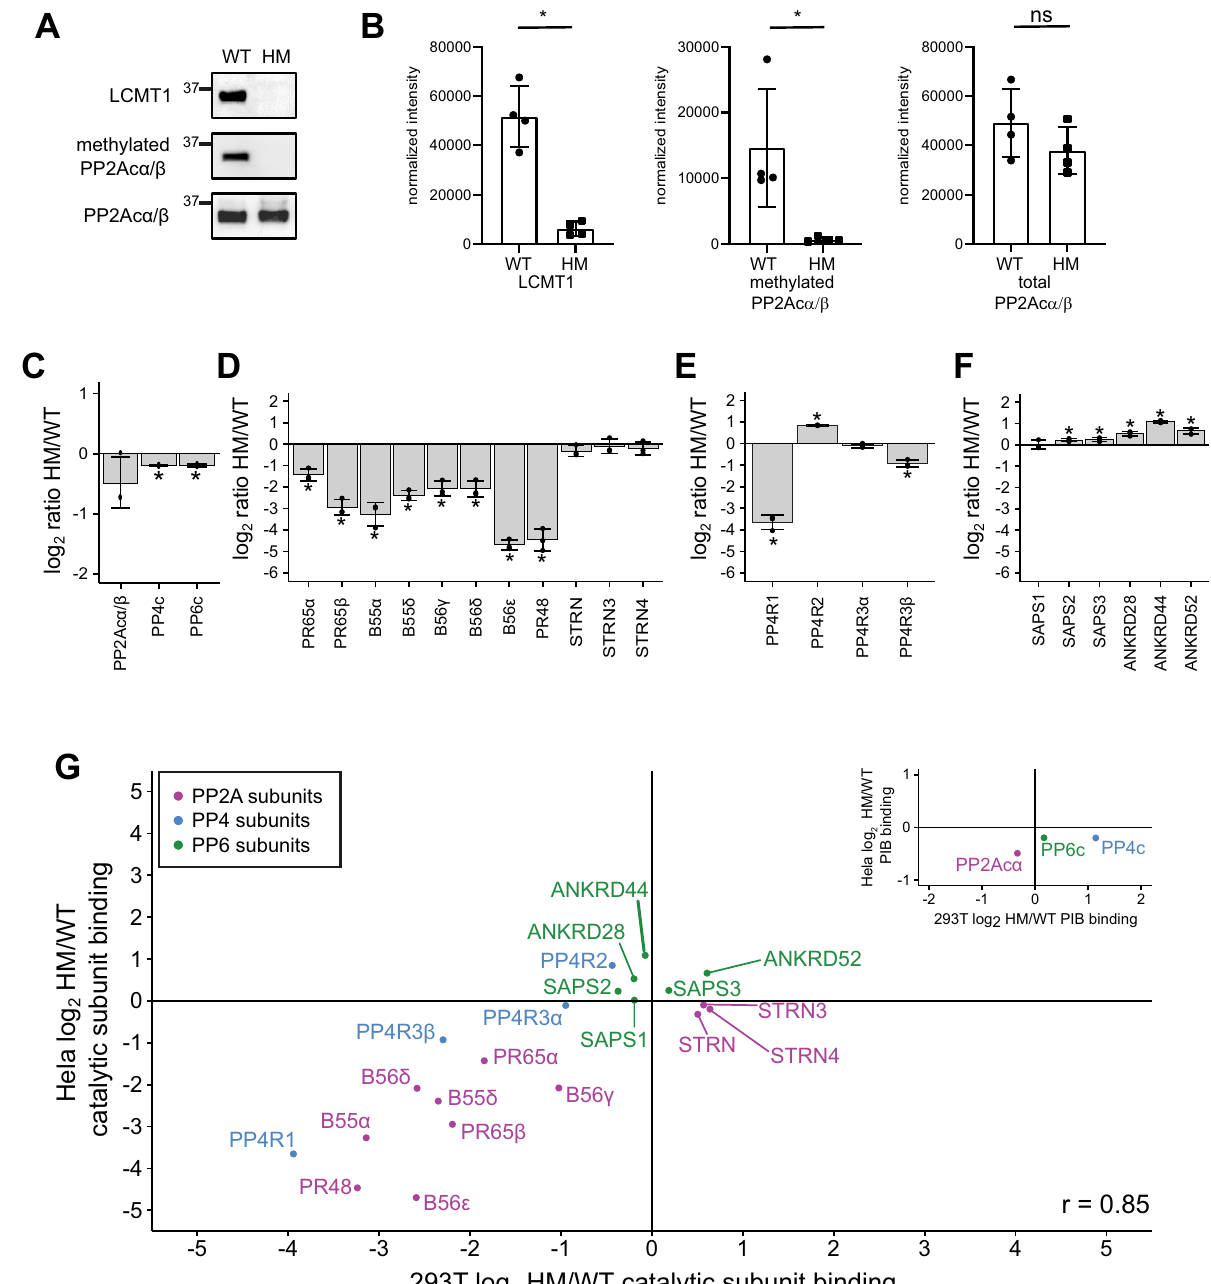
Figure 5. The effects of disrupting LCMT1 expression in HeLa cells on the holoenzyme composition of PP2A, PP4, and PP6. ( A ) Western blots of wild-type (WT) HeLa and a hypomorph (HM) Hela clone probed for LCMT1, methylated PP2Acα/β, and total PP2Acα/β. ( B ) Western blots were quantified, and individual data points are shown for LCMT1, methylated PP2Acα/β, and total PP2Acα/β intensities normalized to total protein loading. Error bars represent the standard deviation of four replicates. Mann–Whitney test was performed * p < 0.05, ns – not significant. The log 2 HM/WT ratio of the abundance of the catalytic subunits ( C ), PP2A subunits ( D ), PP4 subunits ( E ), and PP6 subunits ( F ) bound to PIBs. ( G ) Scatterplot of the log 2 HM/WT ratio of PP2A, PP4, and PP6 subunits PIB binding and normalized to the respective catalytic subunit in HEK293T versus Hela cells. PP2A subunits are labeled in purple, PP4 subunits are in blue, and PP6 subunits are in green. The scatterplot in the upper right depicts catalytic subunit PIB binding in both cell types. * p <